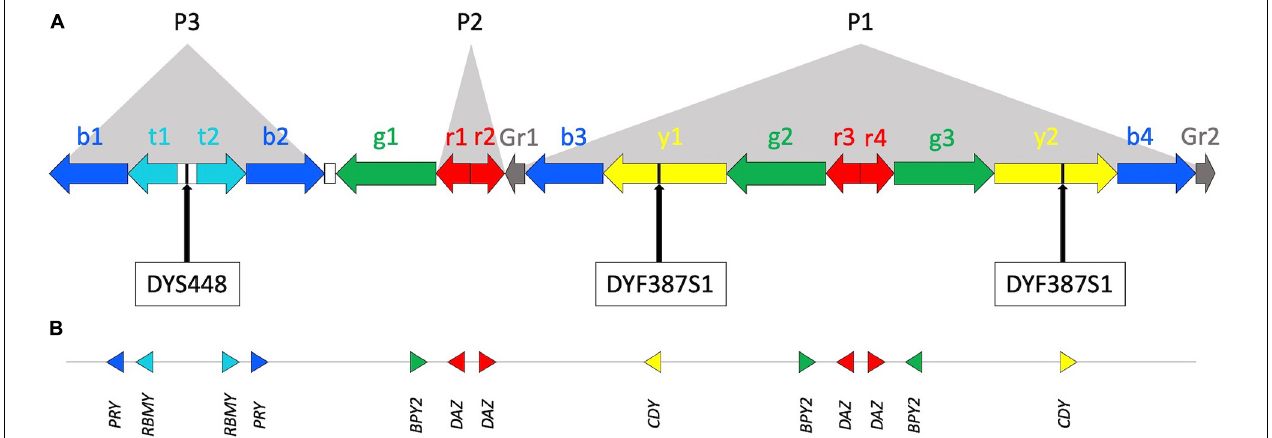
FIGURE 1 | The Y chromosome AZFc region. (A) Multiple copies of six amplicons are represented by color-coded arrows (b—blue, t—teal, g—green, r—red, y—yellow, and Gr—gray; adapted from Kuroda-Kawaguchi et al., 2001; Teitz et al., 2018, not in scale). Arrows direction indicates amplicon copy orientation. Most of the amplicons are arranged to form P1, P2, and P3 palindromes. The white rectangles between t1, t2, and b2, g1 represent the large P3 spacer and a single copy of Inverted Repeats 1 (IR1), respectively. Approximate positions of DYS448 and DYF387S1 short tandem repeats are shown. (B) Locations of protein coding genes within the AZFc. Triangle orientation refers to 5’–3’